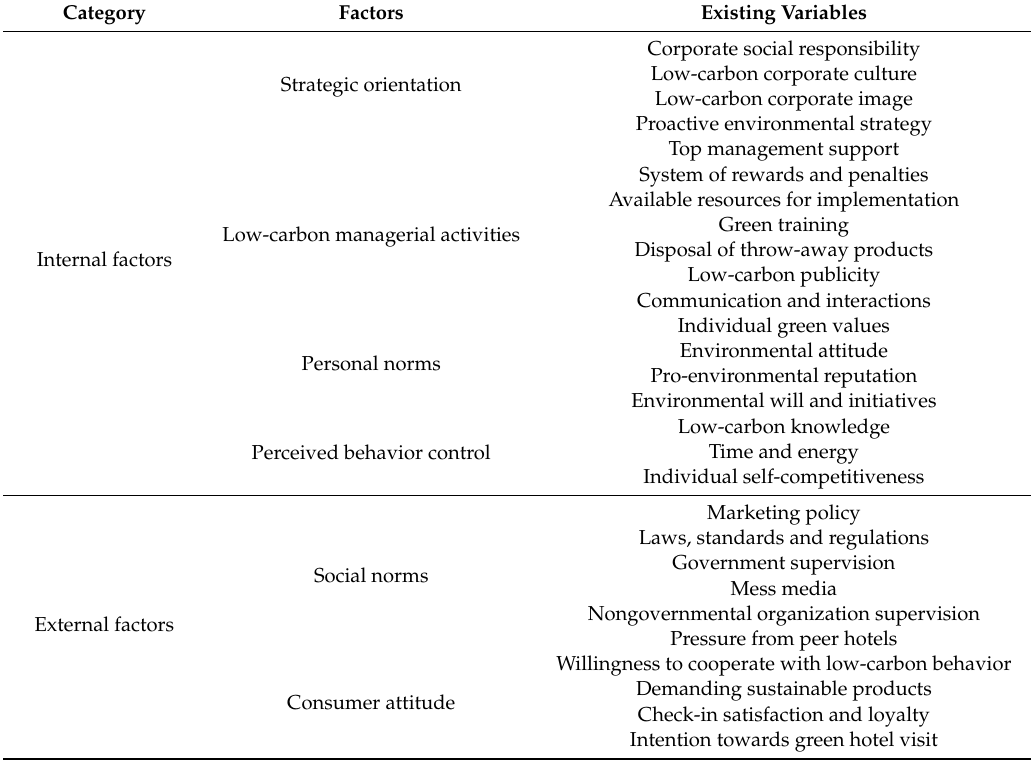
Table 2. Identification of factors influencing low-carbon sta ff behavior in star-rated